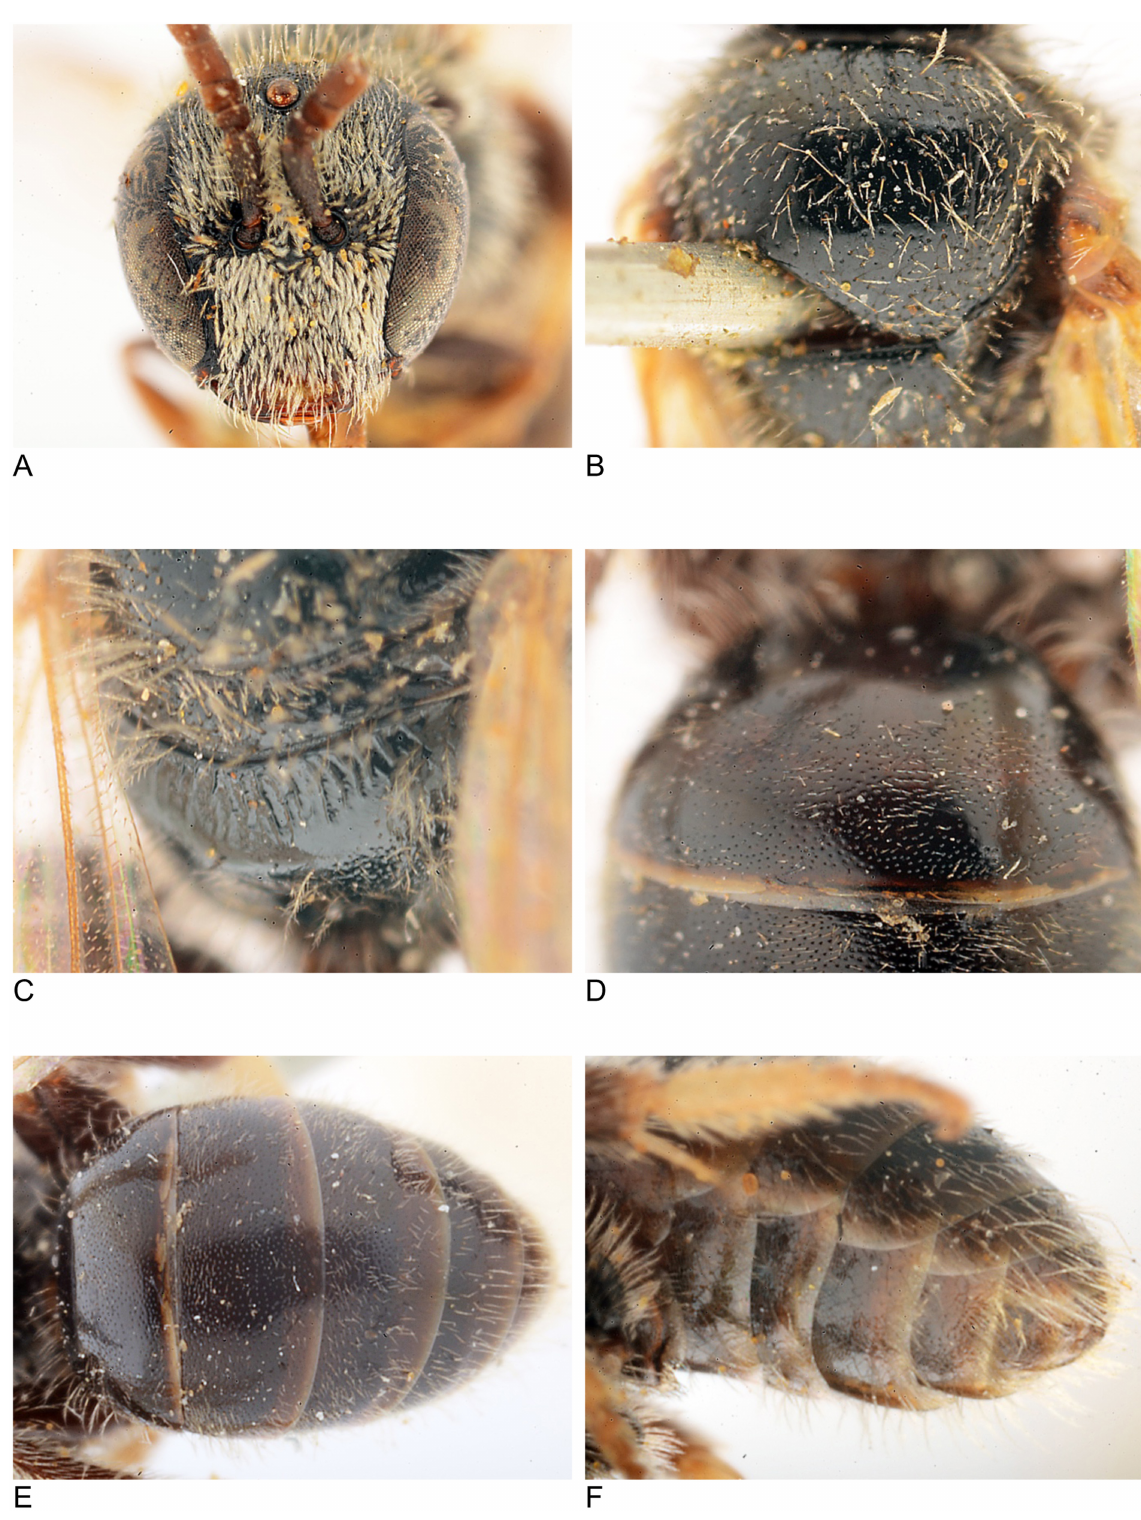
Fig. 8. Halictus pauperatulellus Strand, 1909, holotype, ♂. A . Head. B . Scutum. C . Propodeum. D . First tergum. E . Metasoma, dorsal view. F Metasoma,